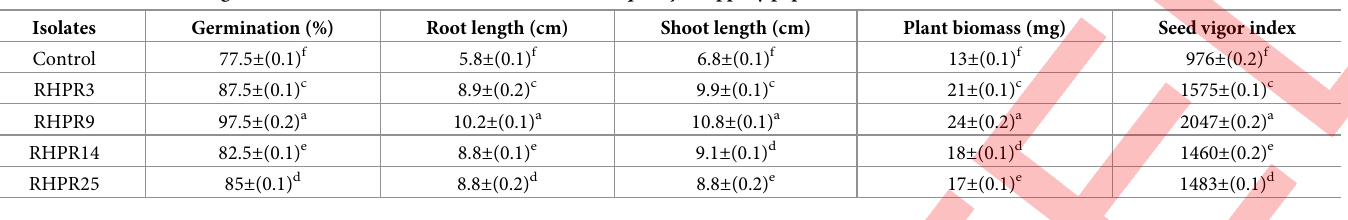
The superscript values, a–f, indicate highest to lowest of significance; the same superscript values a-f according to Fischer’s least significance difference test (p < 0.05) are insignificant. Values in the brackets indicate a standard error, values in a column are the mean of two experiments 6 replications.